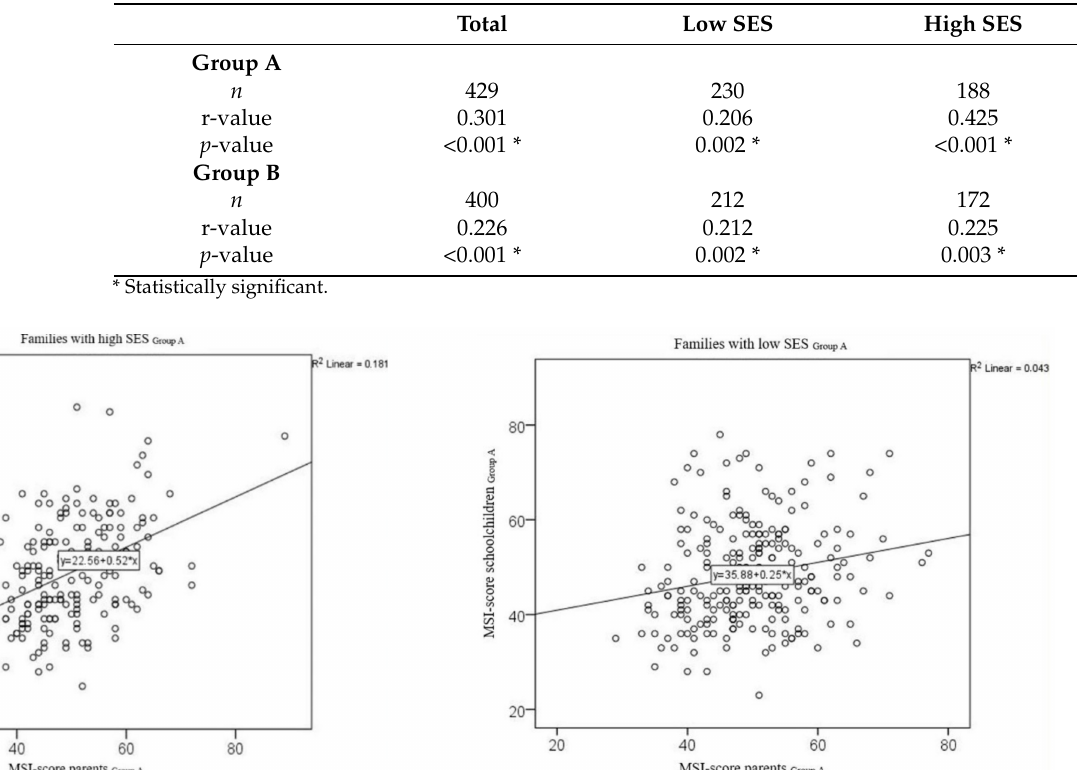
Table 5. Correlation of the MSI scores for all parent–child pairs with different SES from Group A and Group B.